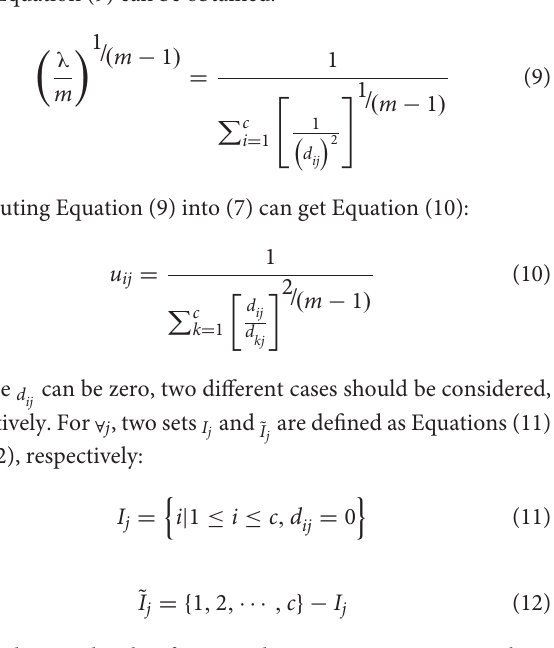
algorithm’s resistance to noise in brain images, and